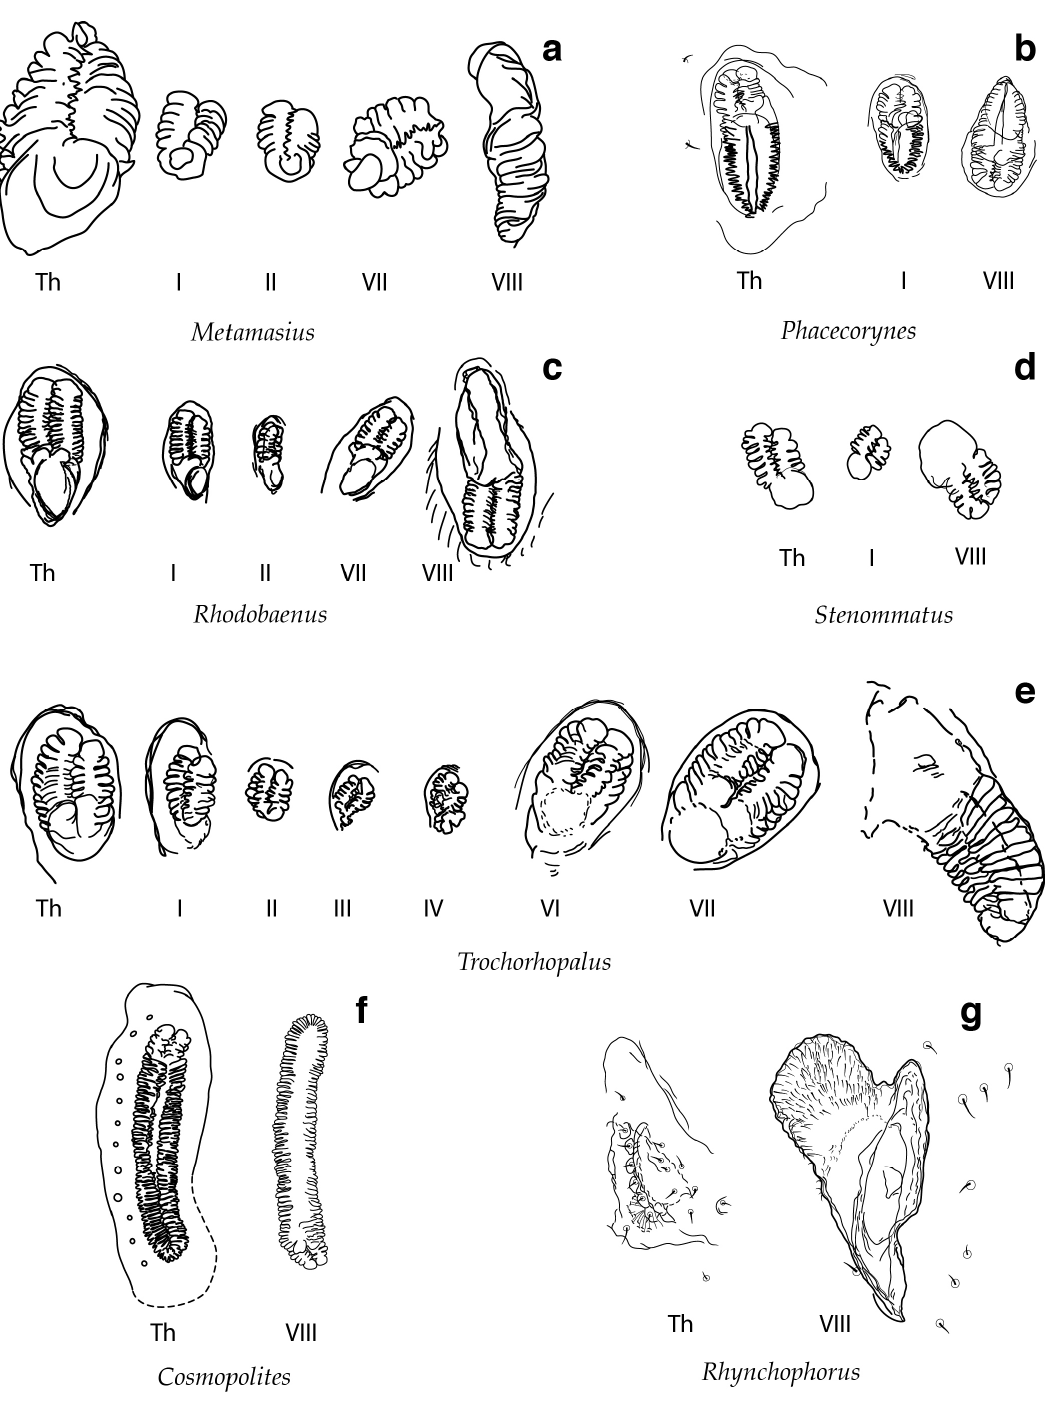
Figure 11. Thoracic and abdominal spiracles, larva: ( a ) Metamasius ; ( b ) Phacecorynes ; ( c ) Rhodobaenus ; ( d ) Stenommatus ; ( e ) Trochorhopalus ; ( f ) Cosmopolites ; and ( g ) Rhynchophorus . 2. Abdominal segment VIII (Figure 12) a. With a pair of digitate projections Dryophthoroides [12], Dryophthorus (reduced) , Mesocordylus (probably) (reduced) , Nephius (=Anius) , Sipalinus , Xerodermus [11,12], Yuccaborus b. Without a pair of digitate projections Cactophagus , Cosmopolites , Cyrtotrachelus , Diathetes , Diocalandra , Dynamis [13], Eucalandra